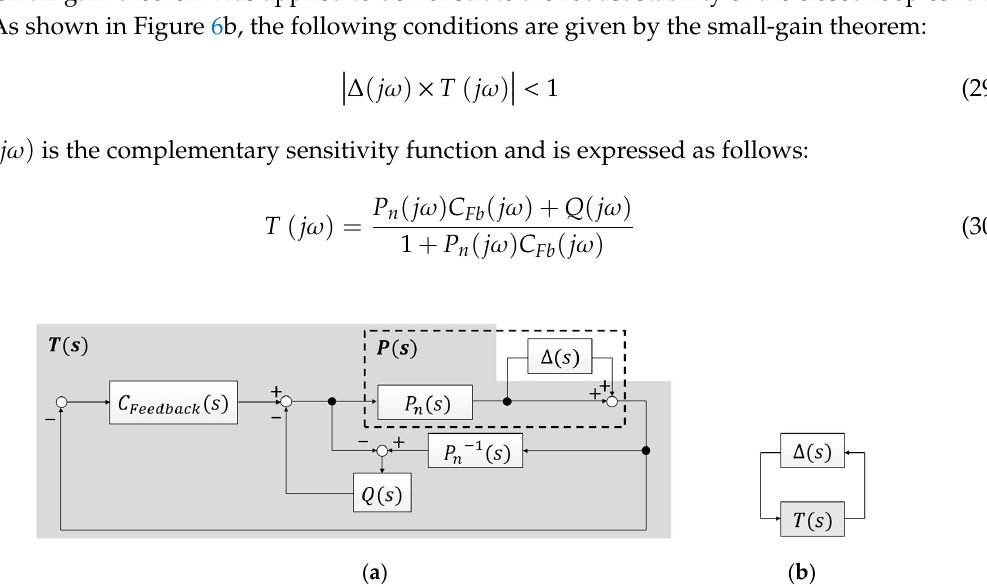
Figure 6. Block diagram of proposed control system: ( a ) Block diagram of the closed-loop control system with multiplicative model uncertainty; ( b ) Equivalent block diagram.